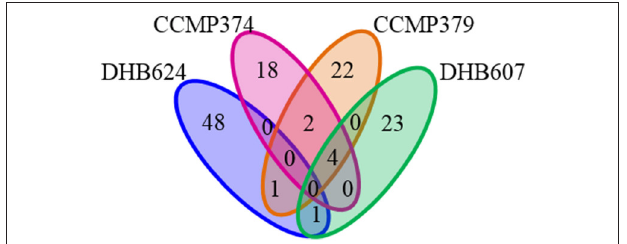
FIGURE 4 | Venn diagram displaying shared metabolites (chemical features) detected in exometabolomes of four Emiliania huxleyi strains. Exometabolomes were generated independently for each E. huxleyi